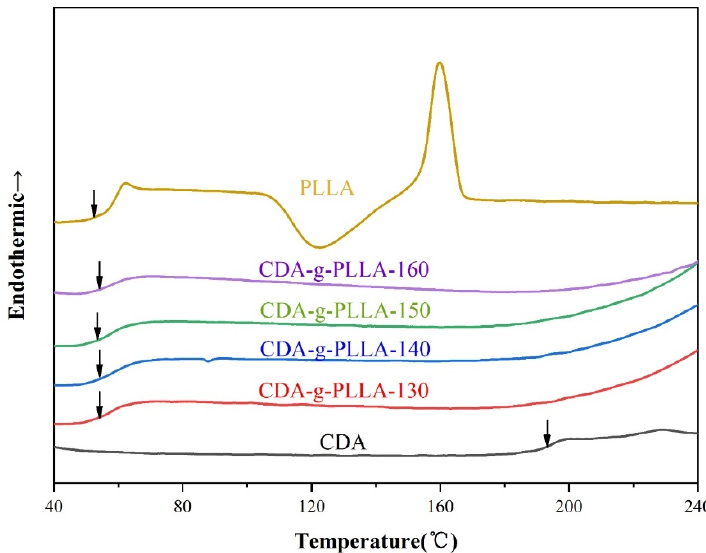
Figure 7. DSC plots of CDA, PLLA, and CDA − g − PLLA with different grafting temperatures.